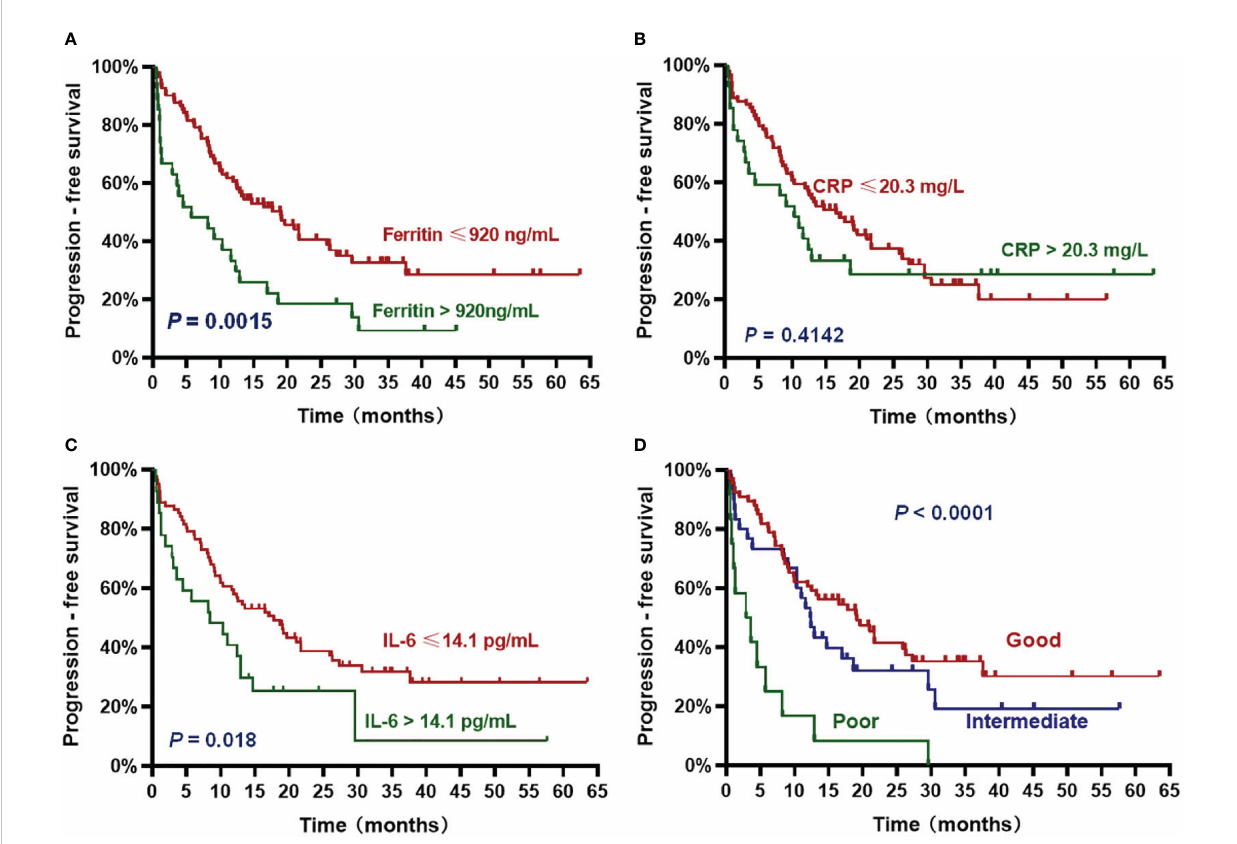
FIGURE 3 Progression-free survival (PFS) according to in fl ammatory markers and InPI index. The patients with ferritin > 920 ng/mL (A) , IL-6 > 14.1 pg/mL (C) and intermediate to poor InPI (D) had inferior PFS. No signi fi cant association was found between CRP and PFS (B) . Survival curves were drawn according to the Kaplan-Meier method. The log-rank test was used to compare the difference in survival probability between two